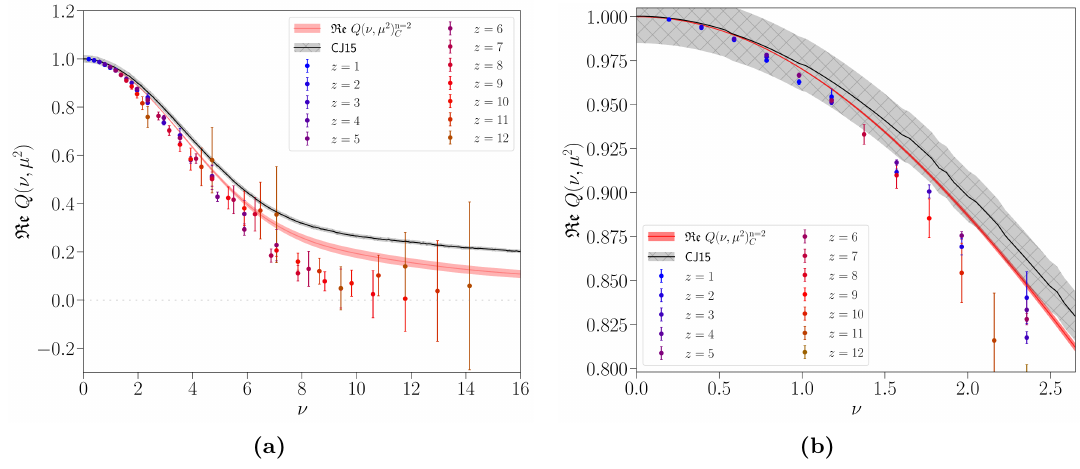
Figure 11. (a) Real component of the matched ITD at µ = 2 GeV in MS fit by the cosine transform of a two-parameter model PDF (4.7). Data have been fit for z/a ≤ 12 and data correlations have been incorporated . The fit clearly misses each point of the ITD. The derived CJ15 ITD at the same scale is shown for reference. (b) Focus is given to the small- ν region. The correlated two-parameter fit is seen to deviate appreciably from the precise small- ν data.